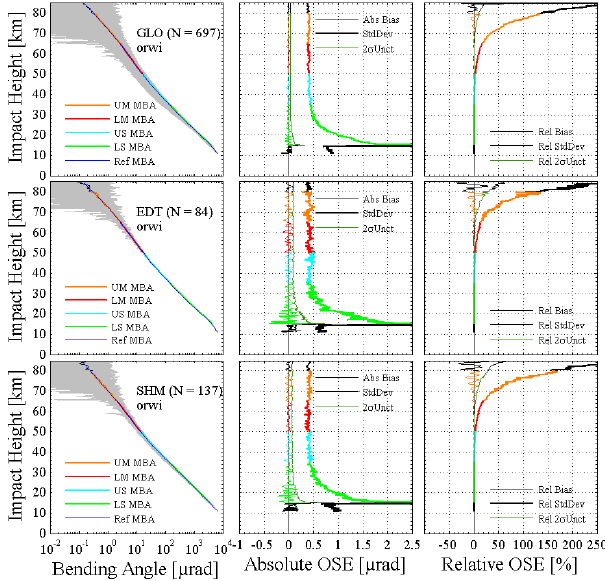
Figure 8. Ionosphere-corrected bending angle profiles and their sta- tistical results for the “orwi” data set. The figure layout and legends are the same as in Fig.